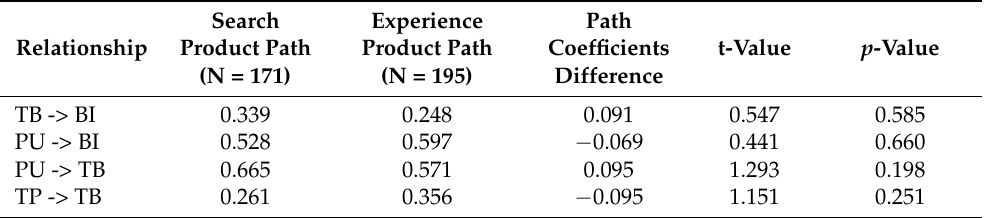
Table 10. Multi-group analysis (PLS-MGA) using Welch-Satterthwait test.